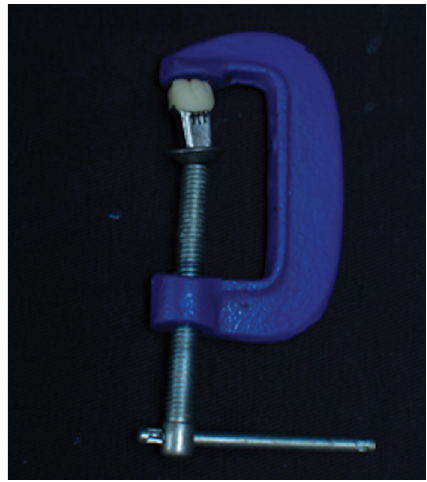
Figure 3. Temporary crown adapted to the metal die with a “C”